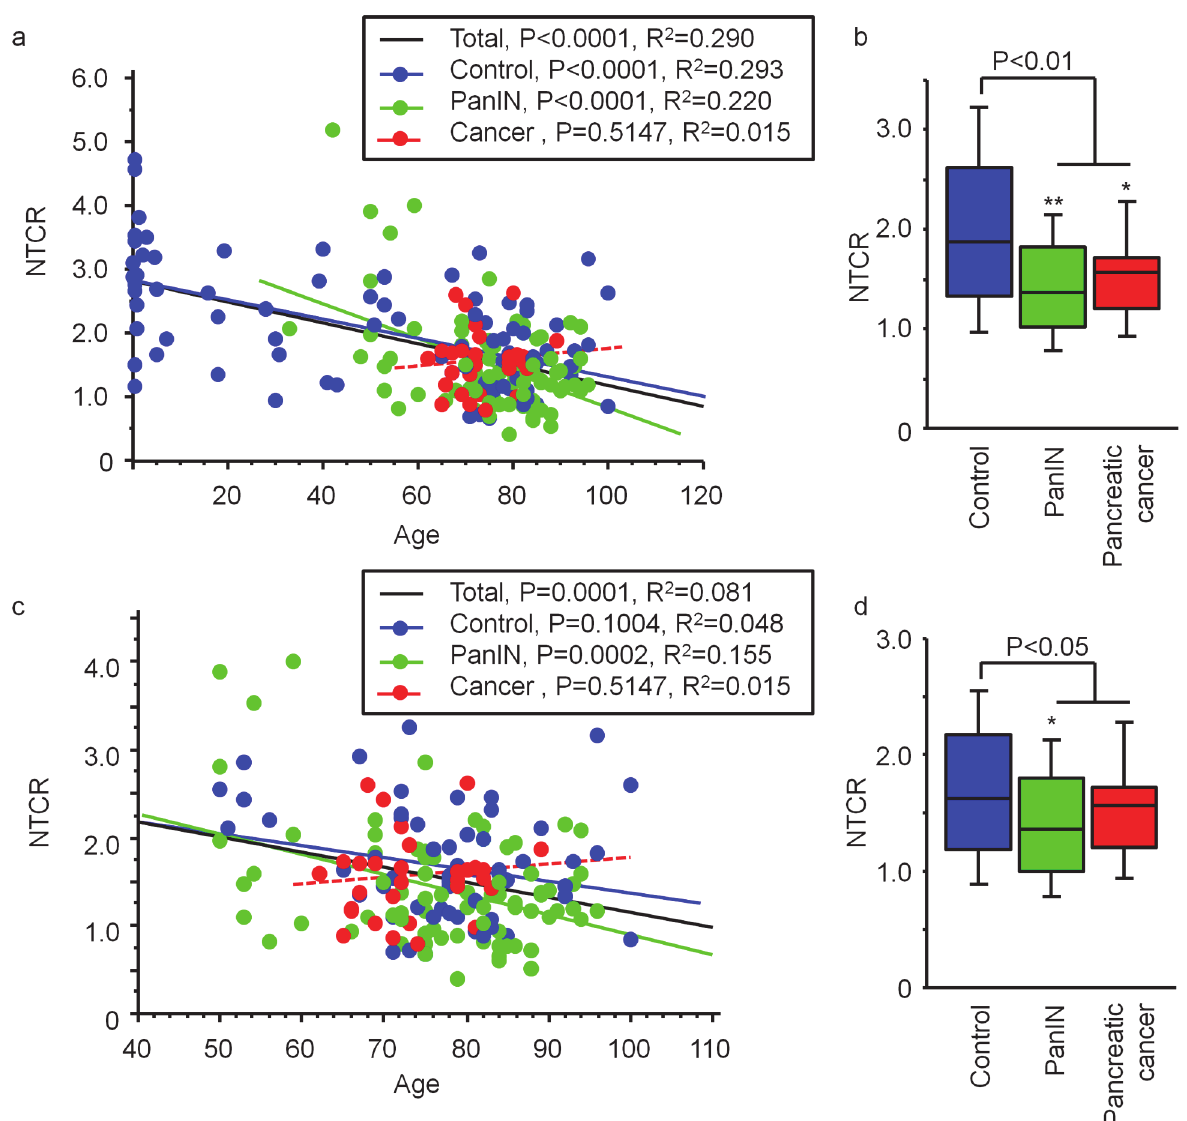
Fig 4. Telomere length in normal duct epithelium from autopsy and surgically resected cases. (a) NTCR in the normal duct epithelium in 150 autopsy and 69 surgically resected cases was negatively correlated with age in the cases overall (n = 219, black), the control group (n = 91, blue) and the PanIN group (n = 92, green), but the relationship was not statistically significant in the pancreatic cancer group (n = 36, red). (b) Comparison of NTCR in the normal duct epithelium between the control, PanIN and pancreatic cancer groups. * P < 0 . 05 vs control. ** P < 0 . 01 vs control. (c) NTCR in the normal duct epithelium from individuals aged over 50 years (n = 182). Blue, control (n = 57); green, PanIN (n = 189); red, pancreatic cancer group (n = 36). (d) Comparison of NTCR in the normal duct epithelium among the control, PanIN and pancreatic cancer groups. * P < 0 . 05 vs